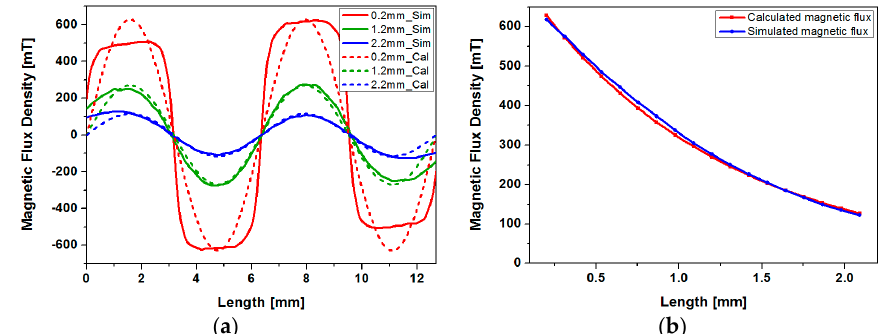
Figure 4. Simulation and curve fitting results of the magnetic flux density at various gaps from the magnet: ( a ) magnetic flux along the x -axis at various gaps (solid line shows the simulation result and dashed line shows the magnetic field distribution represented with sine function); ( b ) maximum magnetic flux density at various gaps.